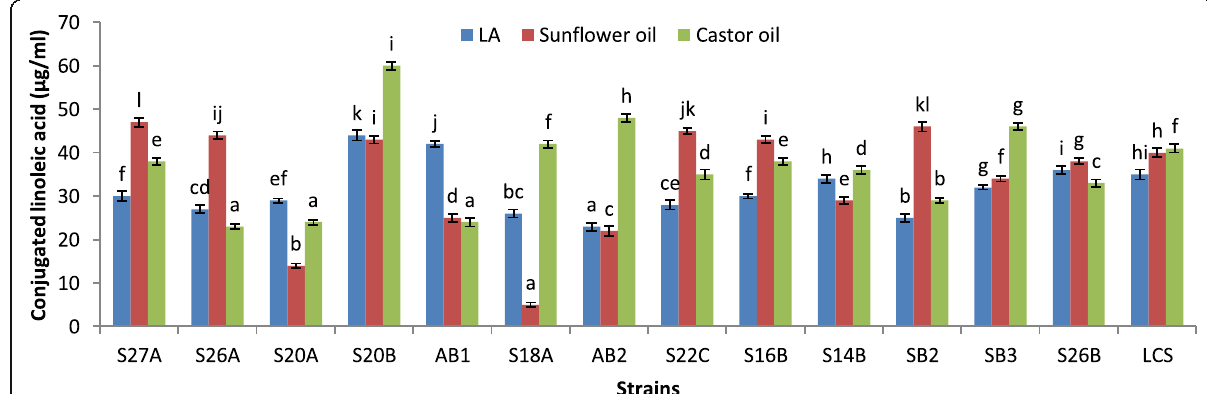
Fig. 2 Production of conjugated linoleic acid from linoleic acid-rich substrates like sunflower oil and castor oil. Highest yield was seen in castor oil by strain S20B. Castor and sunflower oil both can be used as natural substrates for production of